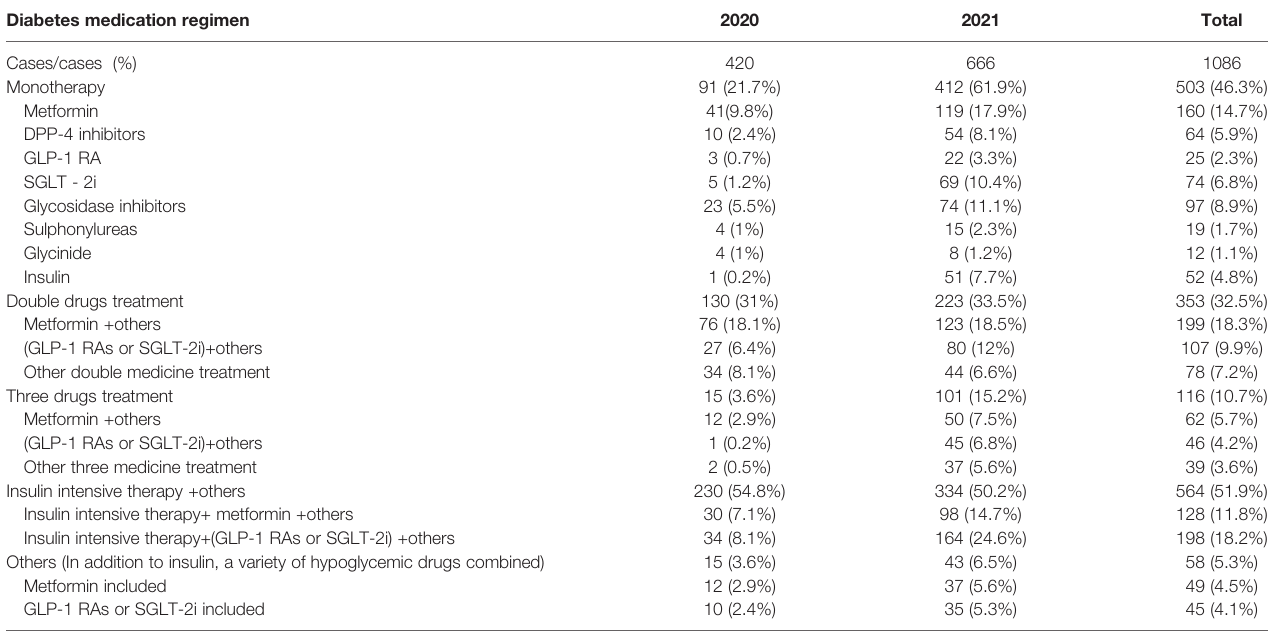
TABLE 2 | Diabetes medication regimen of inpatients with type 2 diabetes.